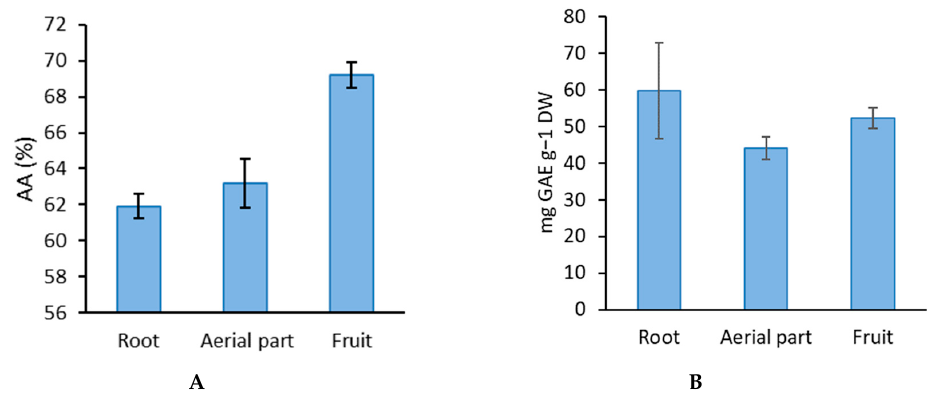
Figure 2. DPPH radical scavenging activity ( A ), total phenolic contents ( B ) of samples. Table 1. Antioxidant activities of the samples from Zosima absinthifolia in thiobarbituric acid (TBA) test. Tested